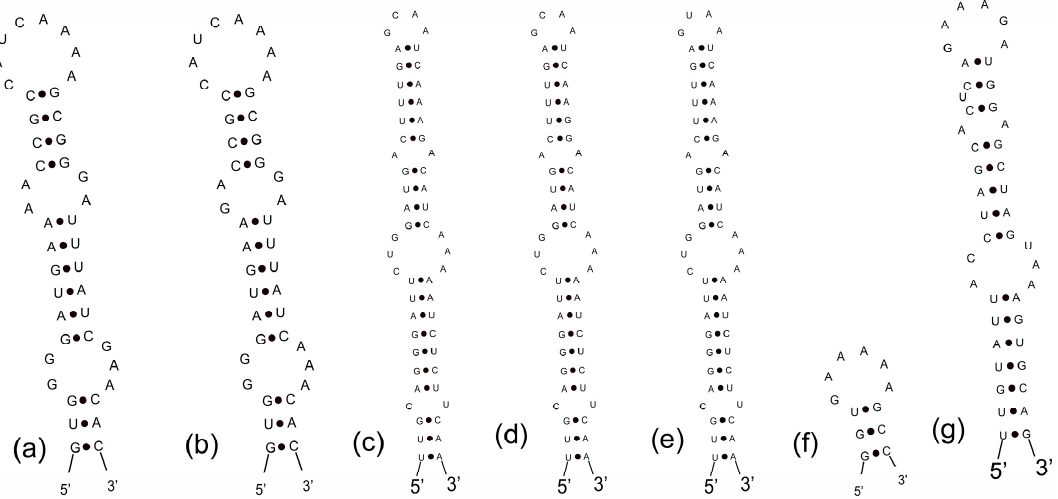
Figure 8. V3 helix of Ancylothrix strains: ( a ) Ancylothrix rivularis WZU 0009; ( b ) Ancylothrix rivularis WZU 0011, 0013, 0014 and Ancylothrix rivularis 7PC, 8PC, 9PC; ( c ) Ancylothrix terrestris 10PC; ( d ) Ancylothrix terrestris 13PC; ( e ) Ancylothrix terrestris WZU 0153, 0154; ( f ) Ancylothrix terrestris 11PC; ( g ) Ancylothrix terrestris 12PC.